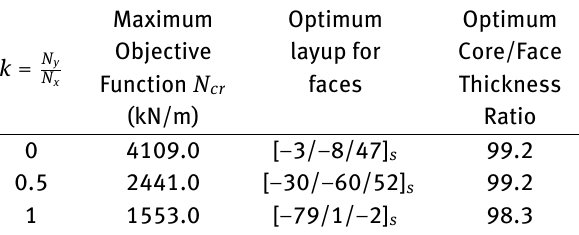
Table 7: Optimisation of a fully clamped sandwich cylindrical panel with honeycomb